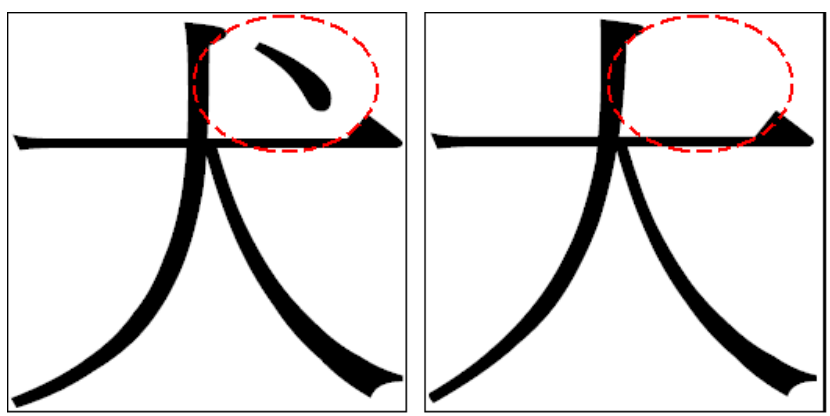
Figure 11. The crucial area for classifying the characters “ 犬 ” and “ 大 ”.